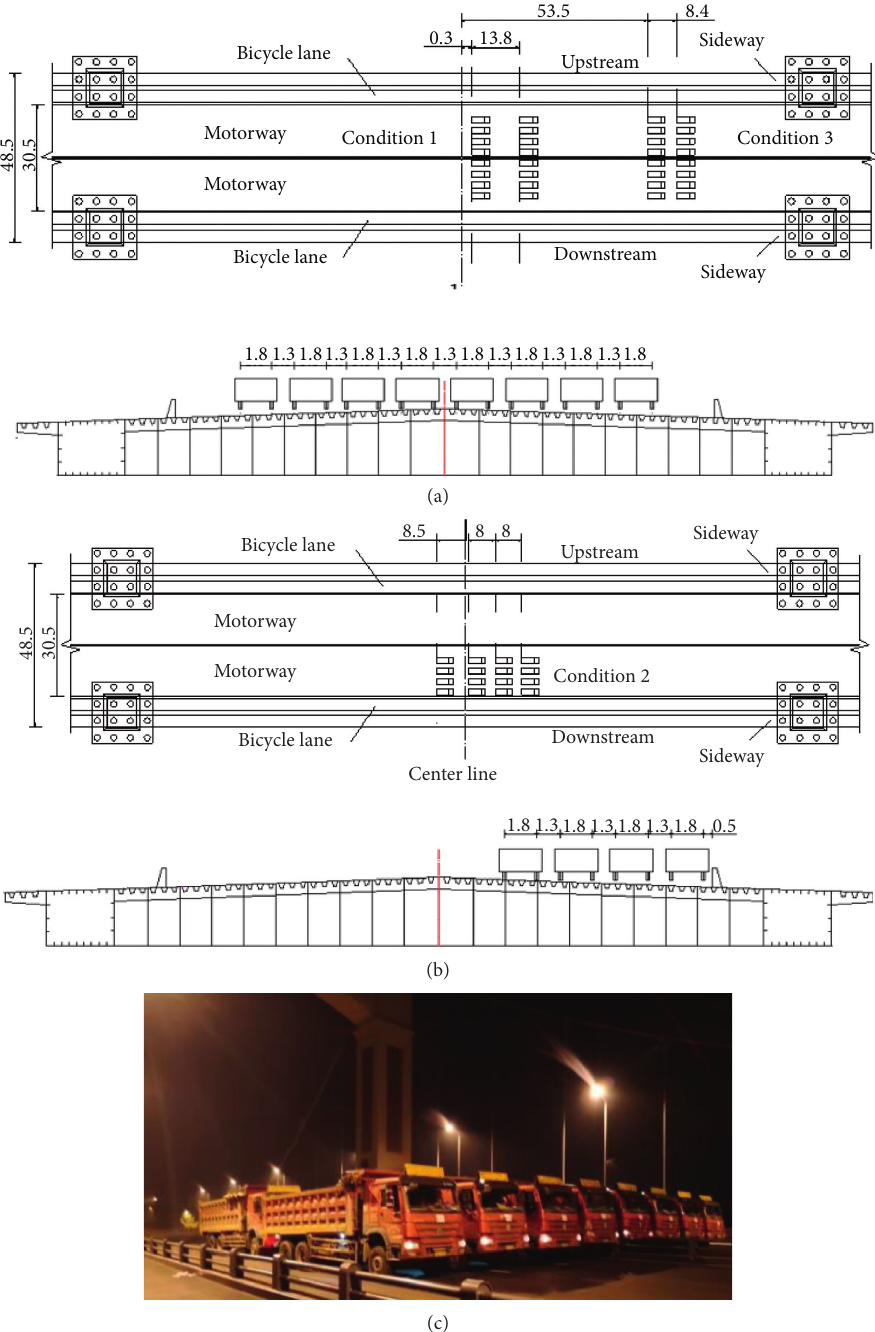
Figure 8: Layout of loading vehicles (unit: m). (a) Symmetrical loading (Conditions 1 and 3). (b) Eccentric loading (Condition 2). (c) Full-scale field